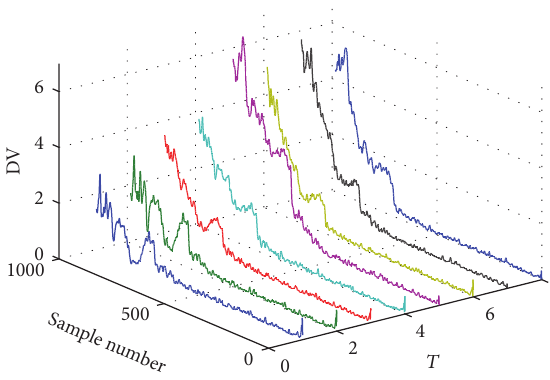
Figure 8: Assessment result with different values of 𝑇 .